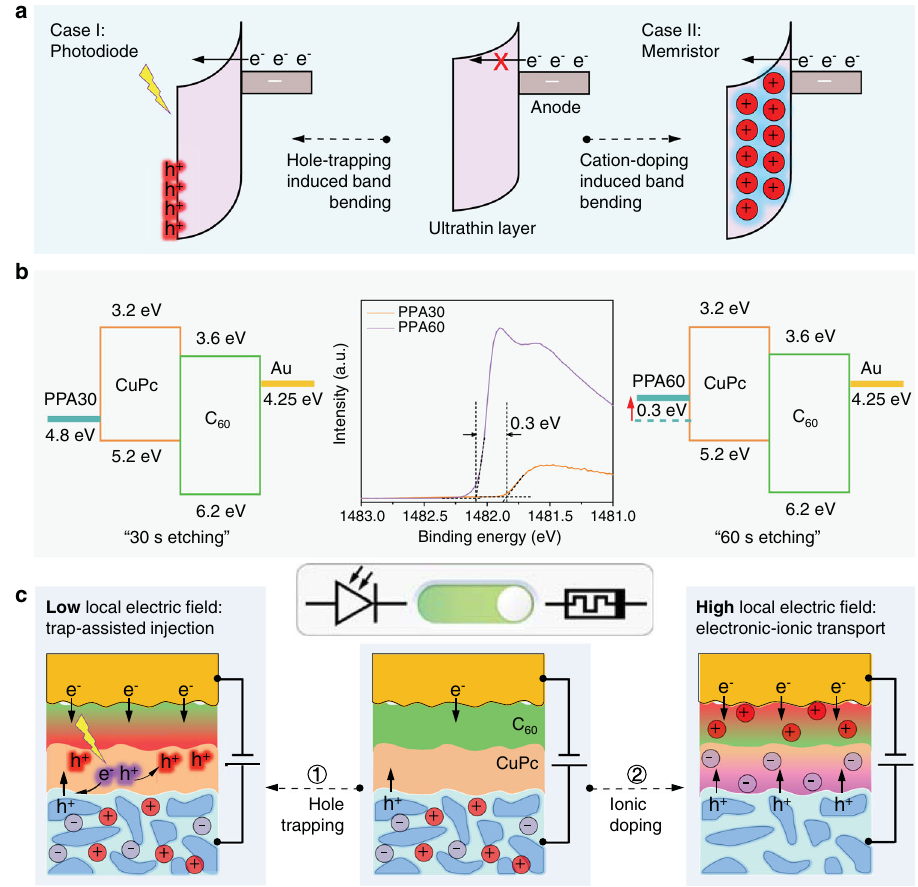
Fig. 5 Mechanism of the electric- fi eld-driven transition. a Both trapped holes and accumulated ions in the vicinity of the electrodes have the same effect, i.e., they induce band bending and enhance the charge injection due to the increase in the local carrier density. Red-glowing “ h + ” , red circle with “ + ” , and black “ e − ” represent the trapped photogenerated hole, accumulated cation, and injection electron, respectively. b Photoelectron spectra (Al K α - monochromated, 300 W, 1486.6 eV) of the wet-etched PEDPT:PSS:AgNWs and the proposed band structures (before equilibrium) with 30 s-etching and 60 s-etching. From the photoelectron spectra obtained by using monochromatic Al K α radiation, the calculated values of the work function for PPA30 and PPA60 are 4.8 eV and 4.5 eV, respectively. c At a low local electric fi eld across the PPA/CuPc interface, electronic transport dominates, resulting in photomultiplication photodiodes as demonstrated in Fig. 3. At a high local electric fi eld across the PPA/CuPc interface, ion migration is activated, resulting in bipolar memristors as demonstrated in Fig. 4. Therefore, by controlling the PPA/CuPc interface electric fi eld, the molecular device can be switched between the photomultiplication photodiode and bipolar